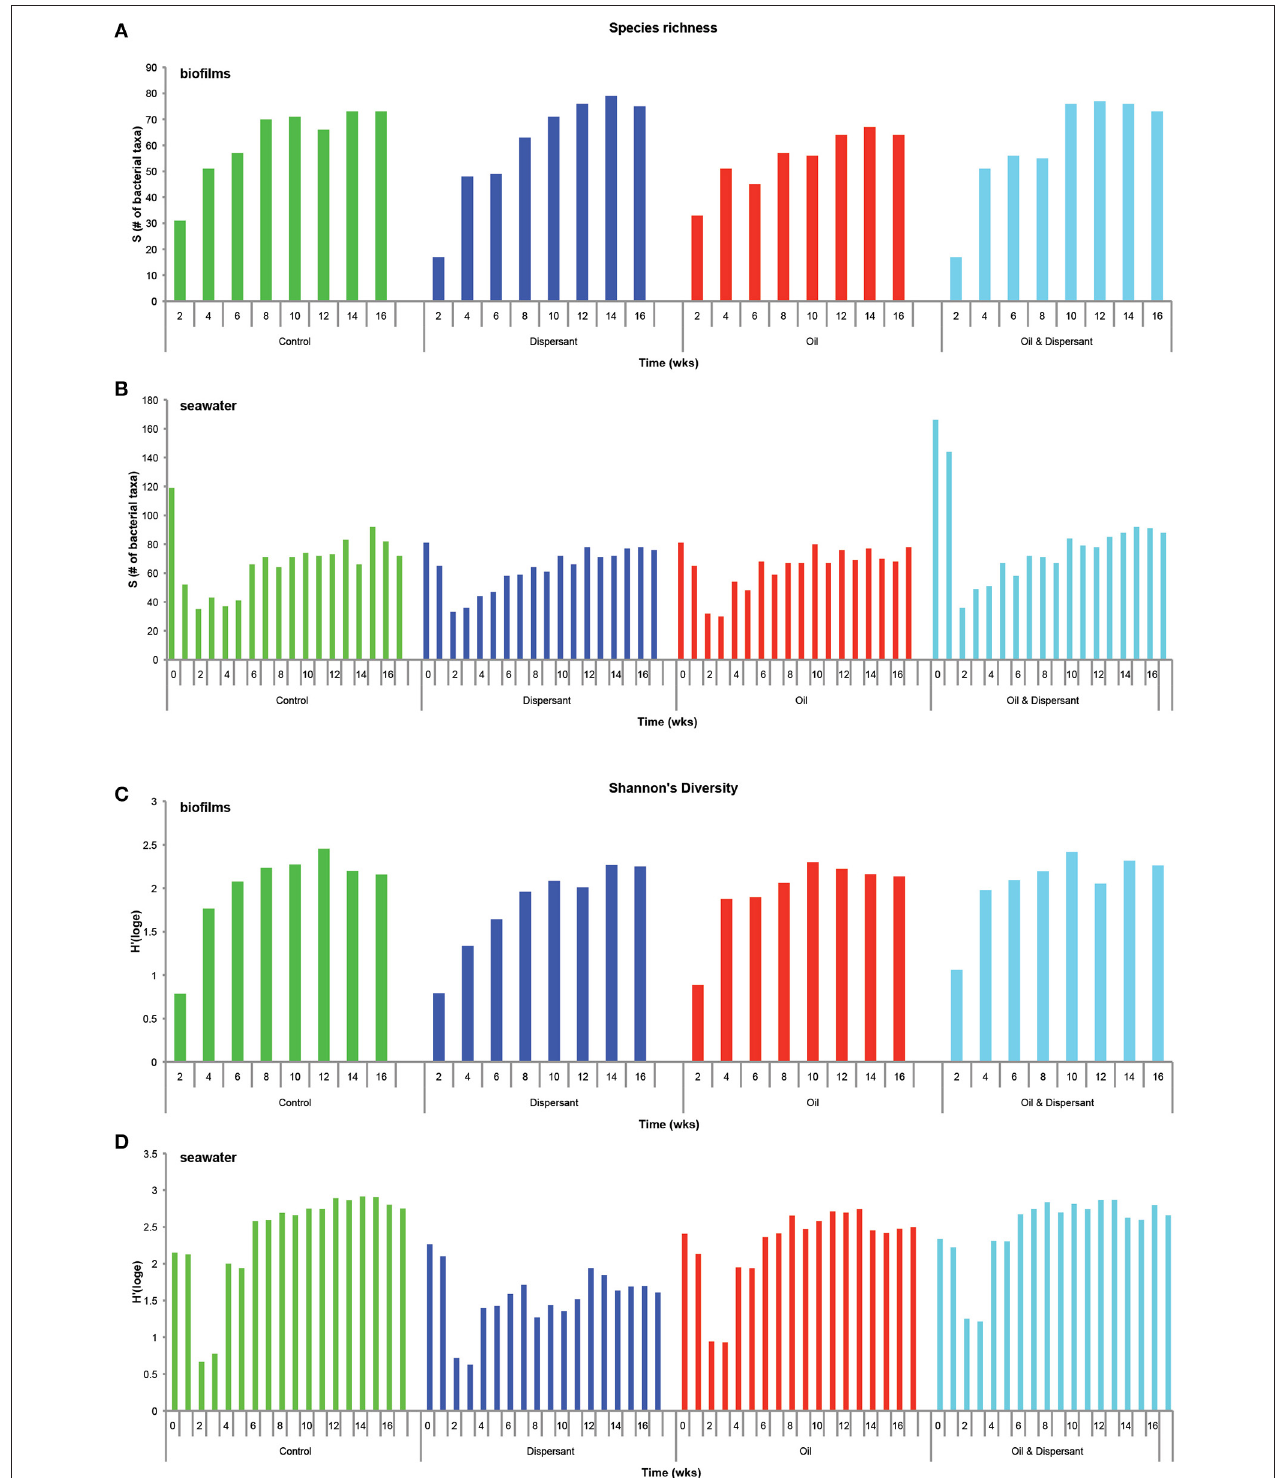
FIGURE 1 | Biodiversity indices for carbon steel disk (CSD) biofilms and seawater bacterioplankton based on total OTUs present in samples. For seawater, each time point has two replicates. (A,B) Species richness (total # of “species”) for biofilms and seawater, respectively; (C,D) Shannon’s diversity index (abundance of individuals and taxa: community with 1 taxon has a value of 0) for biofilms and seawater, respectively.